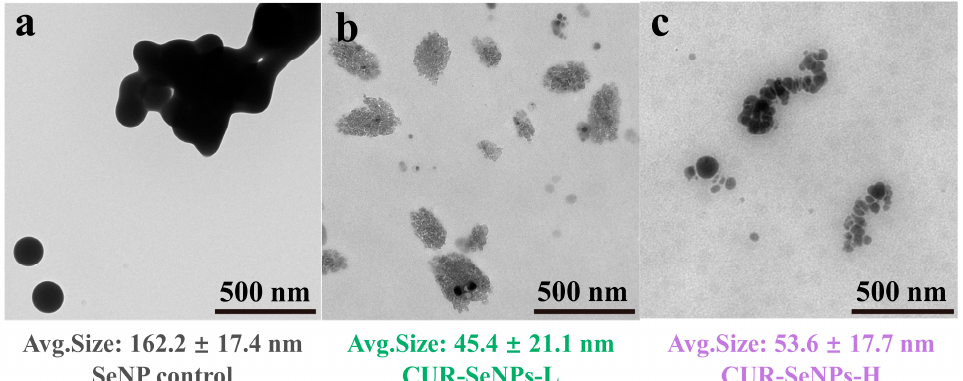
Figure 4. TEM photographs of ( a ) SeNP control, ( b ) CUR-SeNPs-L, and ( c ) CUR-SeNPs-H with their calculated average particle size of SeNPs.